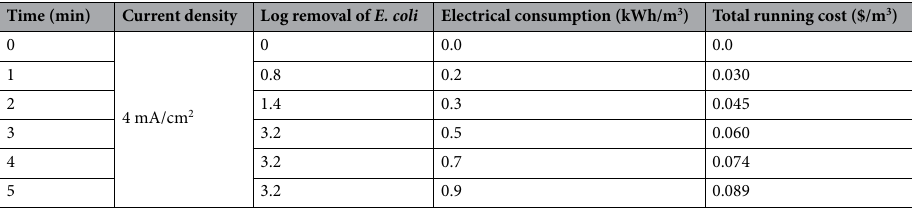
Table 3. Electrical consumption and cost estimation at best-operating